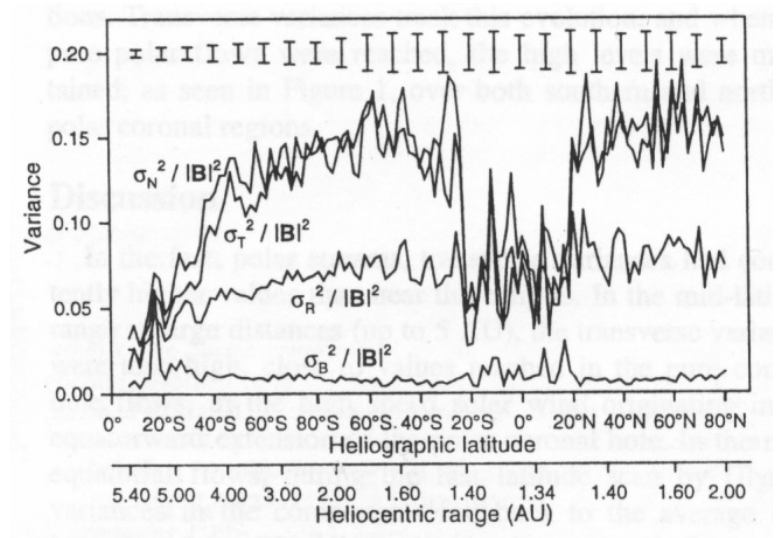
Figure 53: Normalized magnetic field components and magnitude hourly variances plotted vs. helio- graphic latitude during a complete latitude survey by Ulysses. Image reproduced by permission from Forsyth et al. (1996), copyright by AGU.